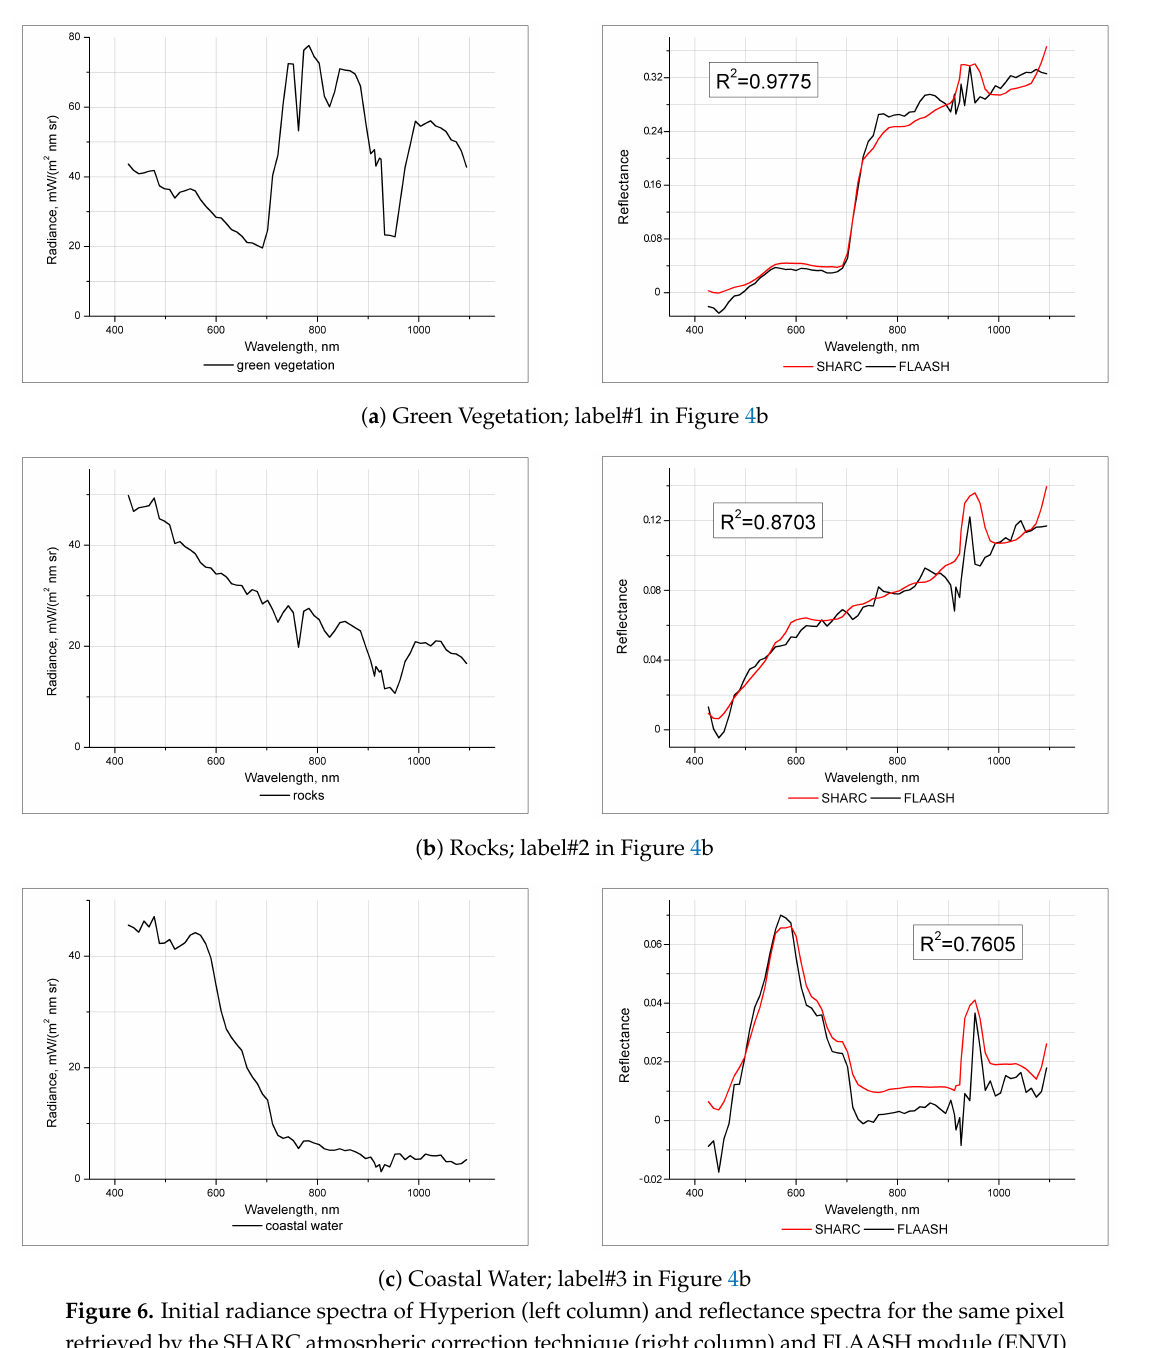
Figure 6. Initial radiance spectra of Hyperion (left column) and reflectance spectra for the same pixel retrieved by the SHARC atmospheric correction technique (right column) and FLAASH module (ENVI) (right column) for three types of underlying surfaces (green vegetation ( a ), rocks ( b ), coastal water ( c )), labeled with pins in Figure